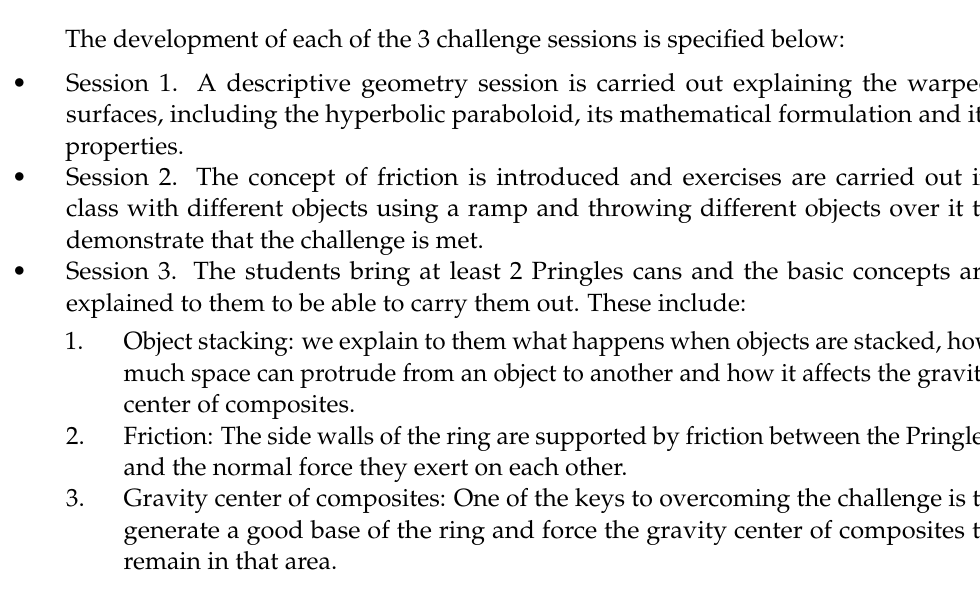
Figure 3. The Pringles